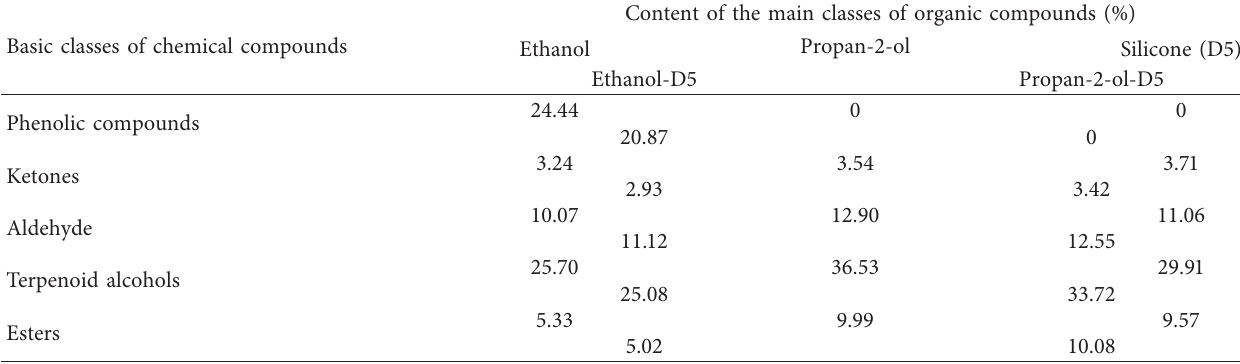
Table 2: Comparative characteristics of the percentage content of the main classes of extracts obtained by different solvents. Basic classes of chemical compounds